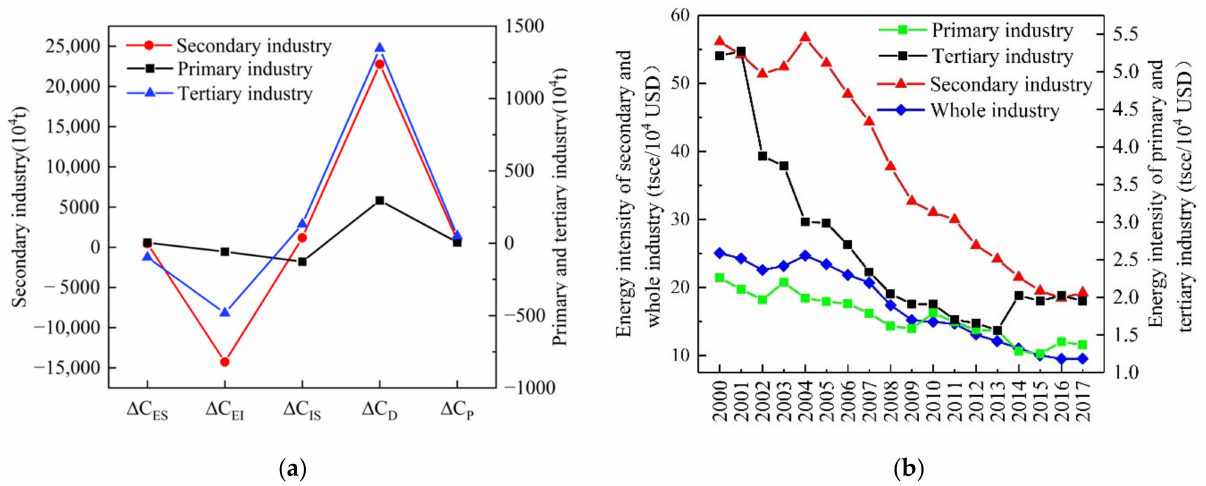
Figure 5. ( a ) The cumulative contribution values of different effects in each industry during 2000–2017 and ( b )the energy intensity of various industries in